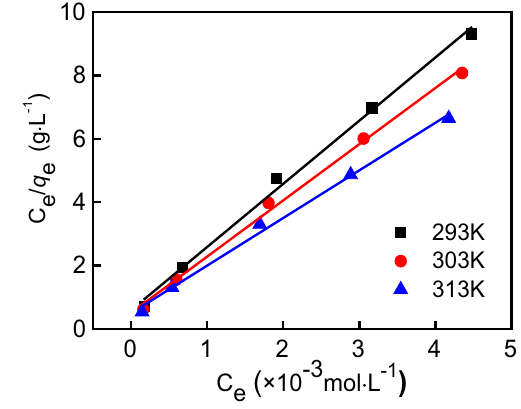
Fig. 6 Effect of initial ion concentration on the adsorption of Co(II) onto the DTC resin